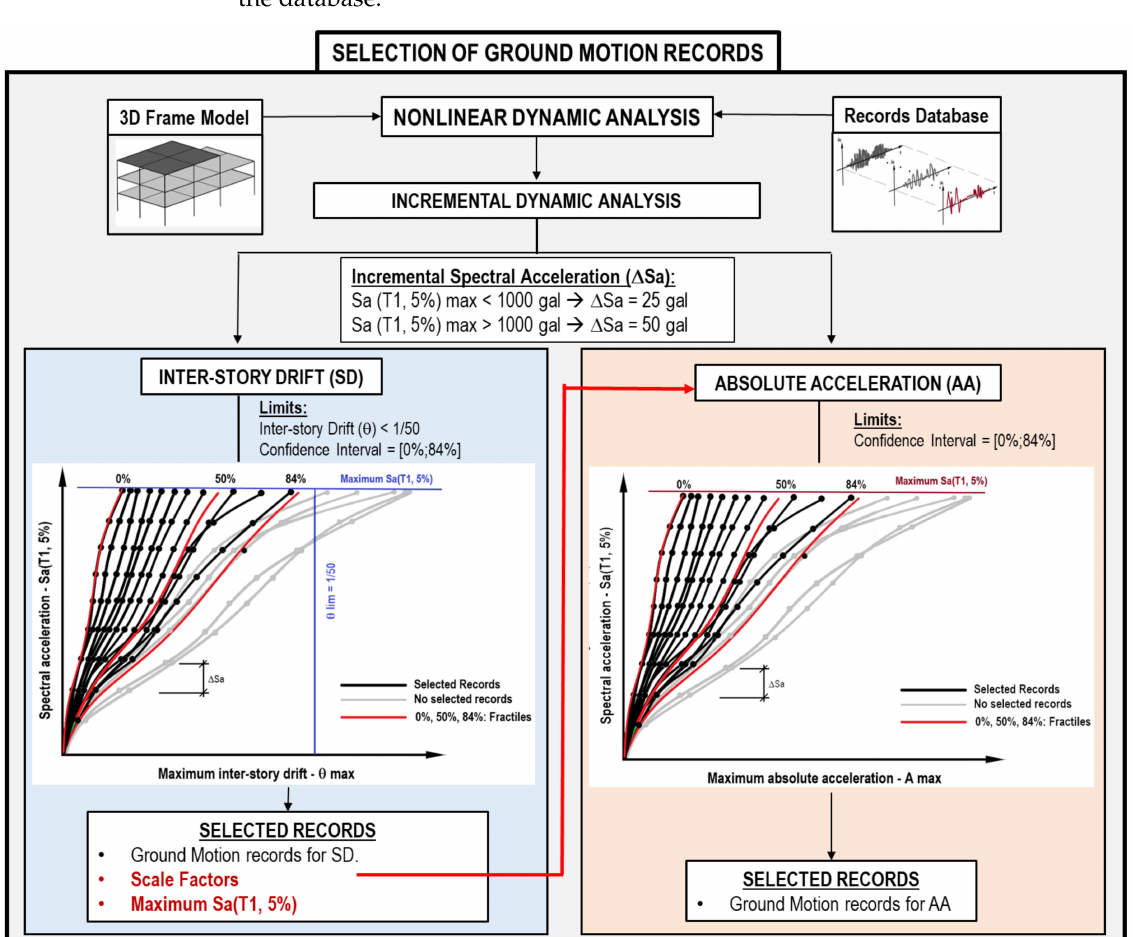
Figure 9. Selection of ground motion records for inter-storey drift and acceleration